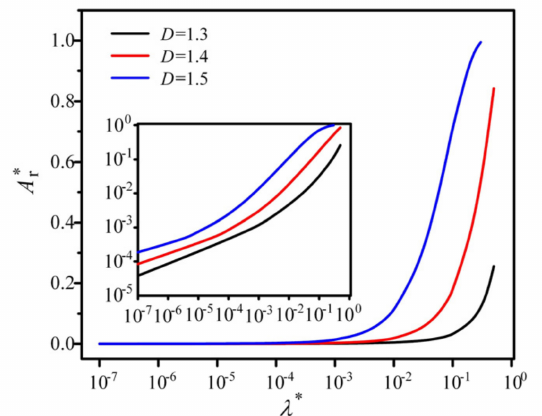
Figure 6. The real contact area versus observation scale λ * with various D